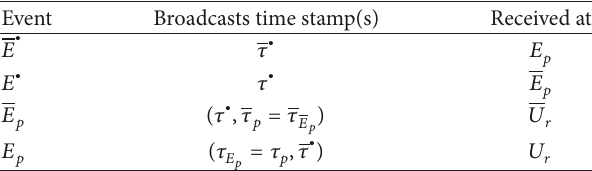
Figure 1: The causal structure of the RPS.